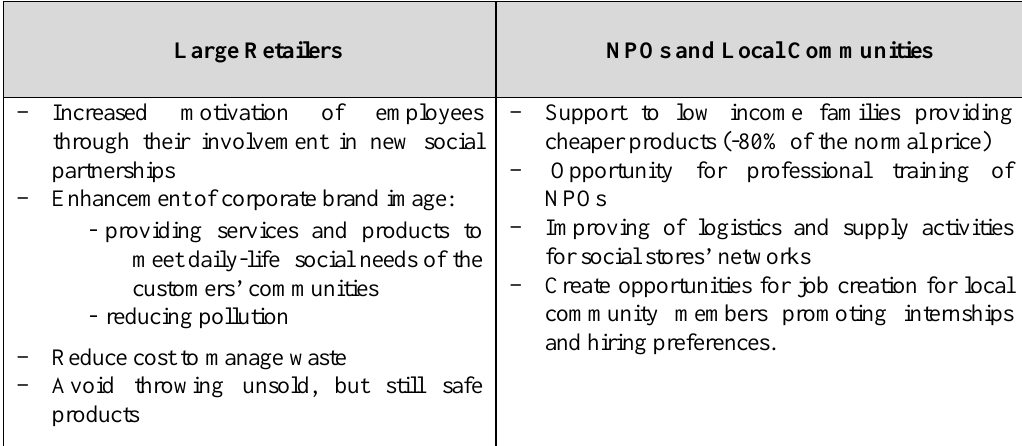
Table 1: Benefits from Solidarity Store Partnerships